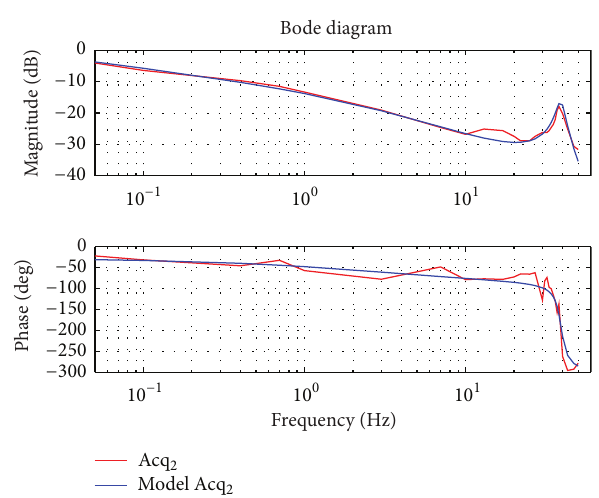
Figure 5: Magnitude and phase of the model on Acq 2 data via